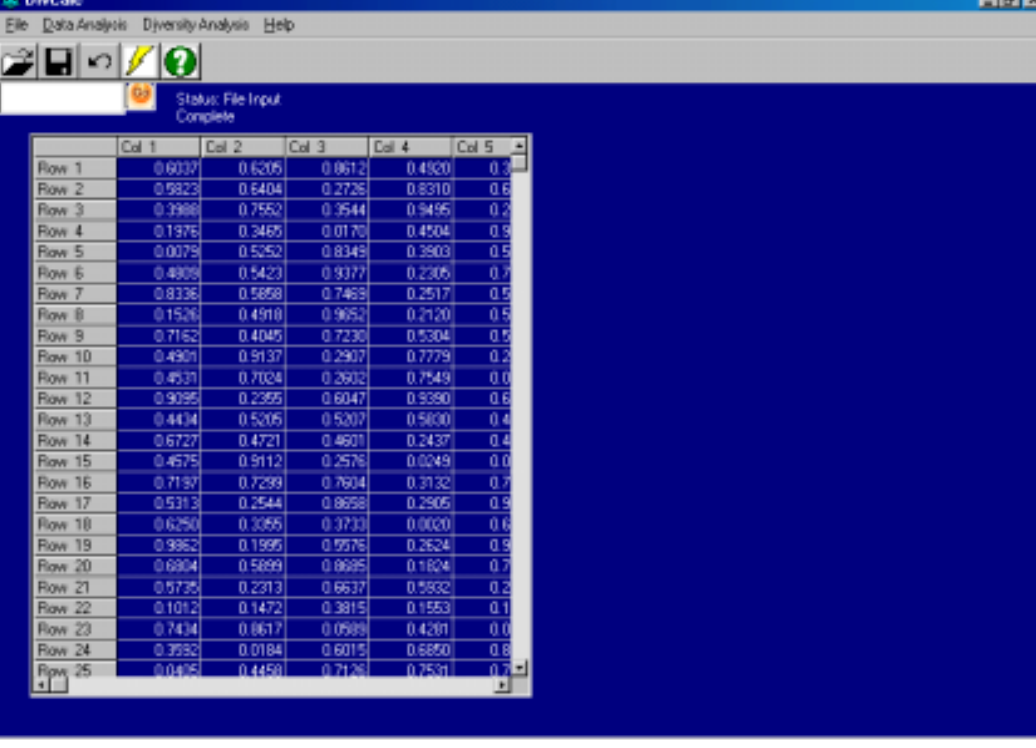
Figure 2. Data Analysis Menu screenshot: